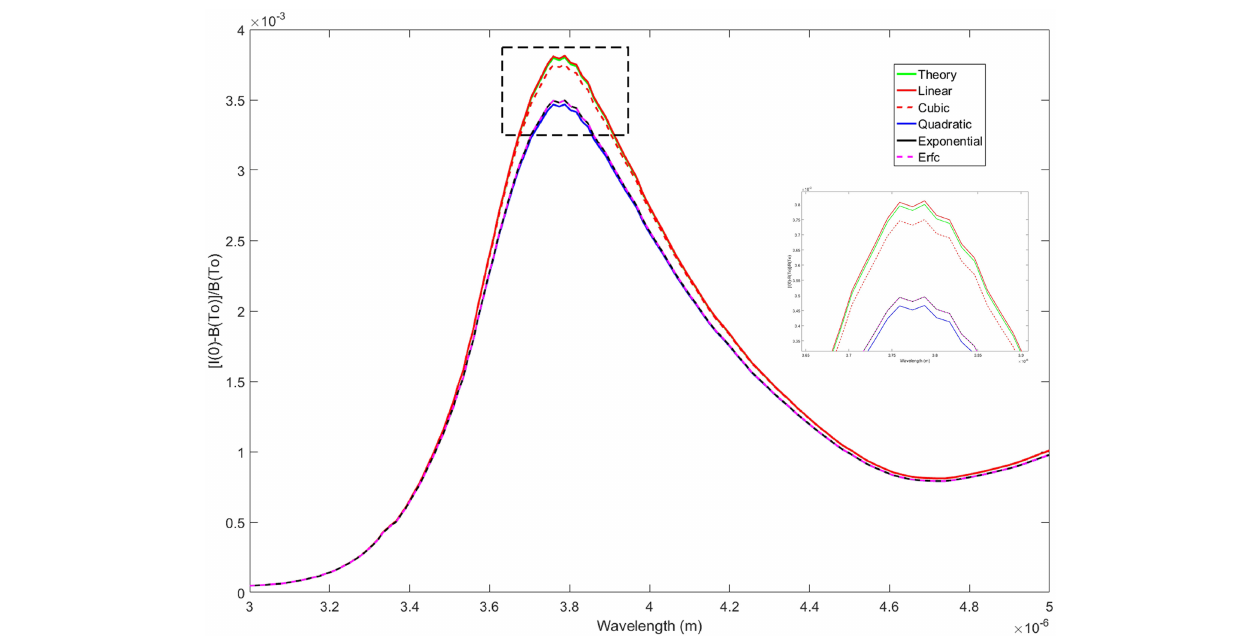
FIGURE 11 | Comparison of MWIR radiation emitted from an air-water surface made dimensionless with the Planck spectrum for several thermal stratifications for a constant surface heat flux condition. The inset is a magnified view of the dashed rectangle surrounding the peak of the curves at λ